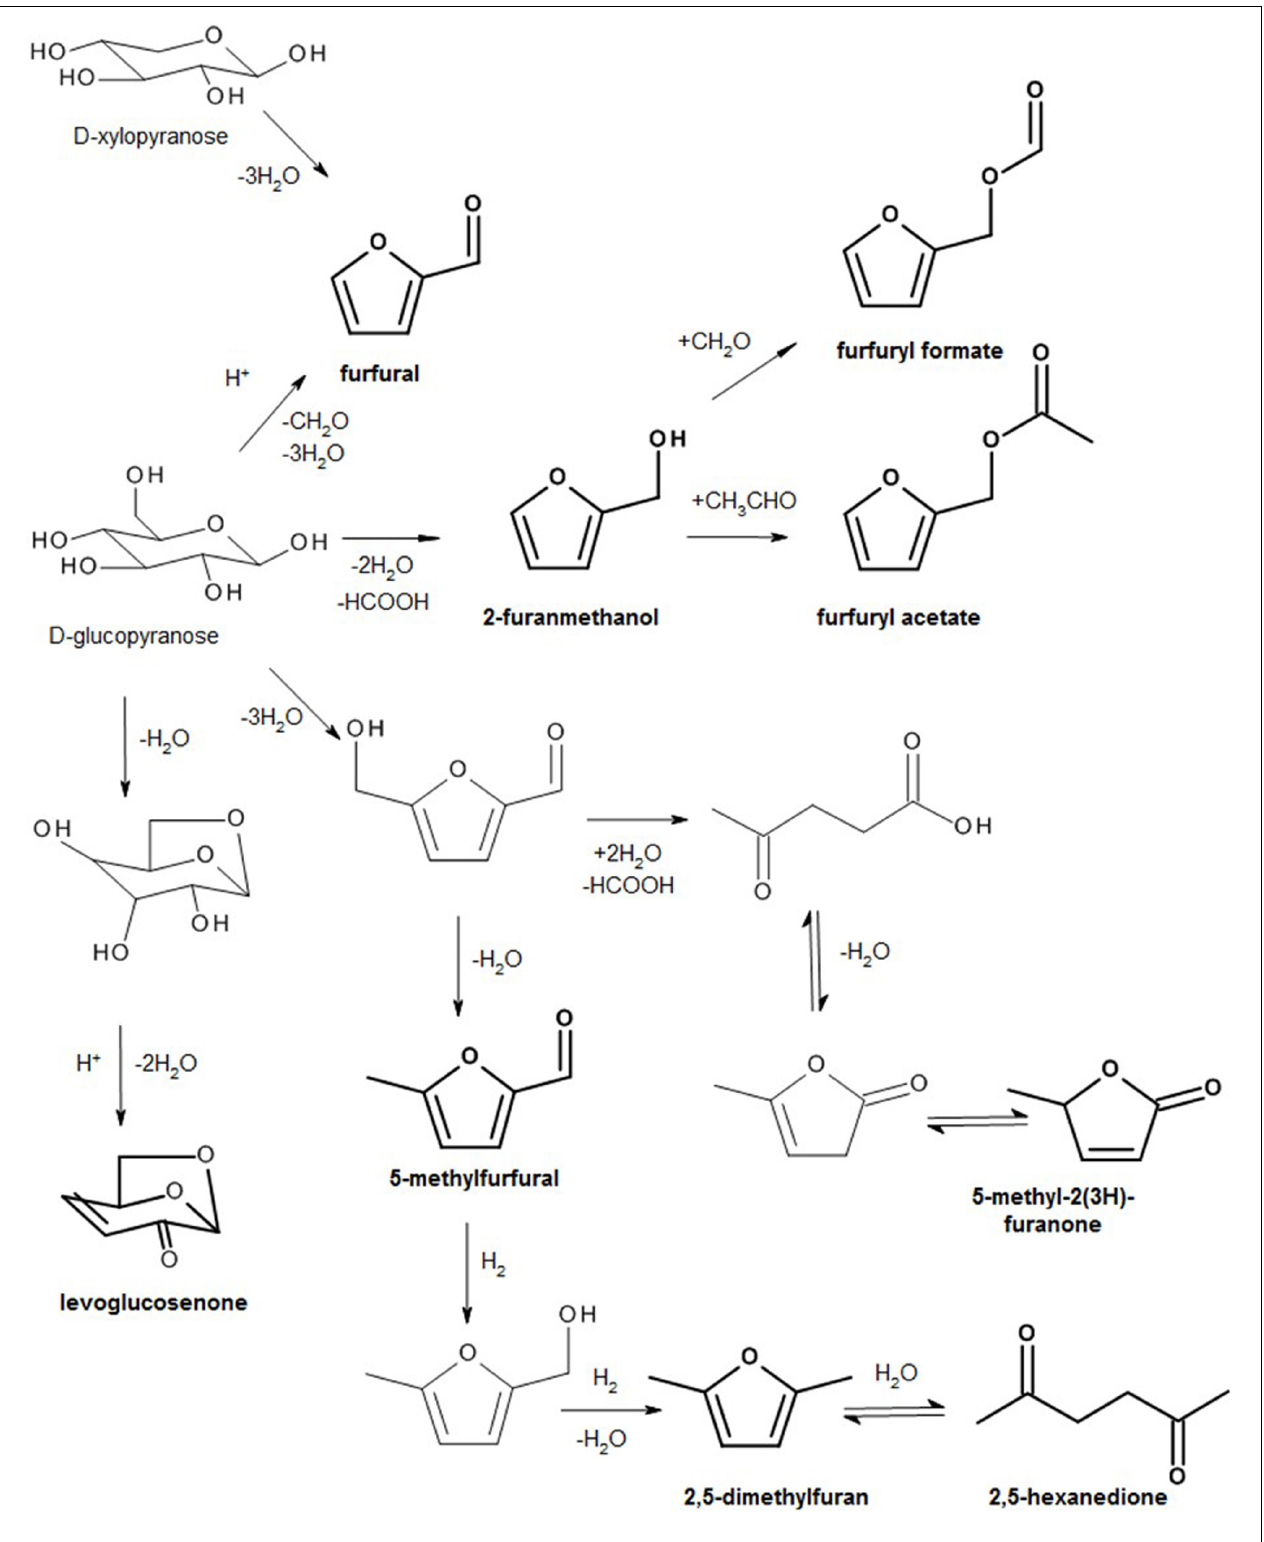
FIGURE 3 | Primary holocellulose decomposition products and their dehydrated derivatives through funneling pathways (Shen and Gu, 2009; Binder et al., 2010; Mäki-Arvela et al., 2012; Al-Shaal et al., 2015; Badji, 2017).